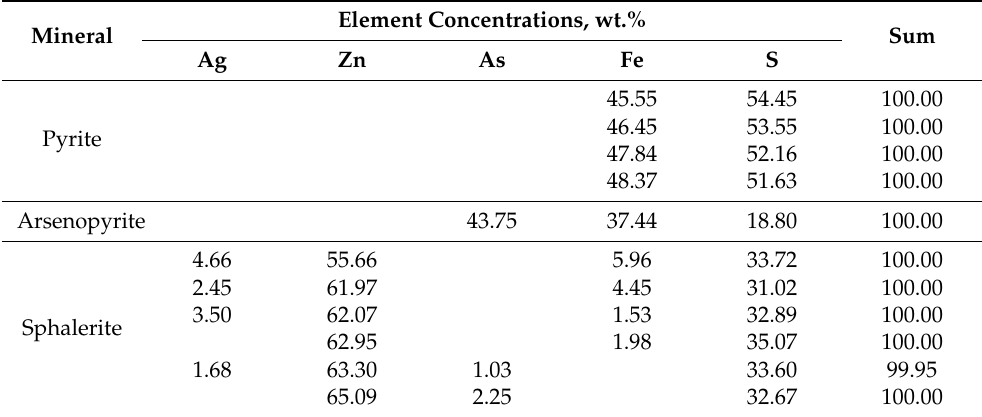
Table 2. Compositions of sulphides (below, and in Tables 3–5, the analyses are not 100% standard-